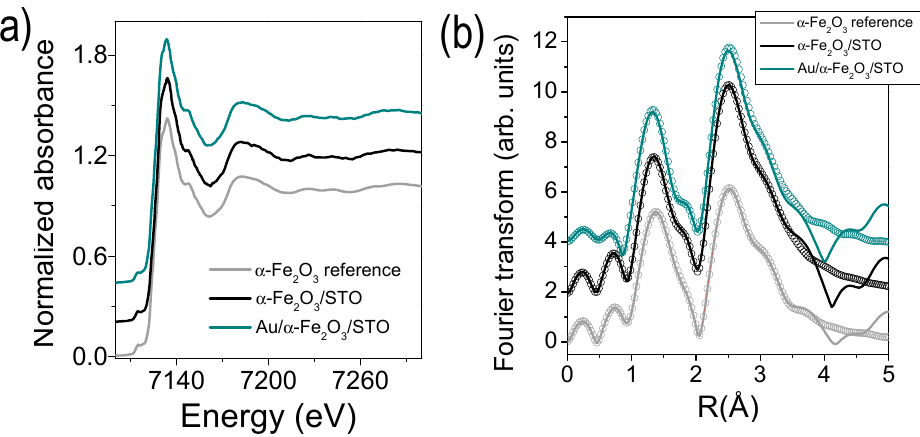
Figure 6. ( a ) XANES spectra and ( b ) FT modulus of the EXAFS signal (lines with symbols) and best- fitting simulations (continuous lines) at the Fe K-absorption edge of α -Fe 2 O 3 layer and Au/ α -Fe 2 O 3 bilayer grown on STO(111) substrates. XANES spectrum and FT of the EXAFS signal of α -Fe 2 O 3 powder reference are presented for comparison.